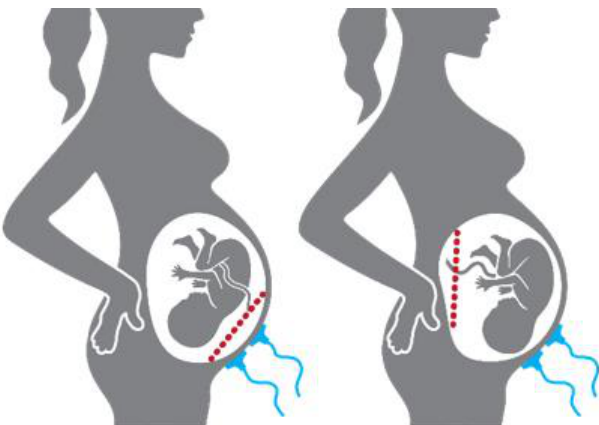
Figure 1. Placental position relatively to the acquisition electrodes (blue): ( Left ) anterior placenta (red dash line); ( Right ) an example of non-anterior placental position (red dash line).